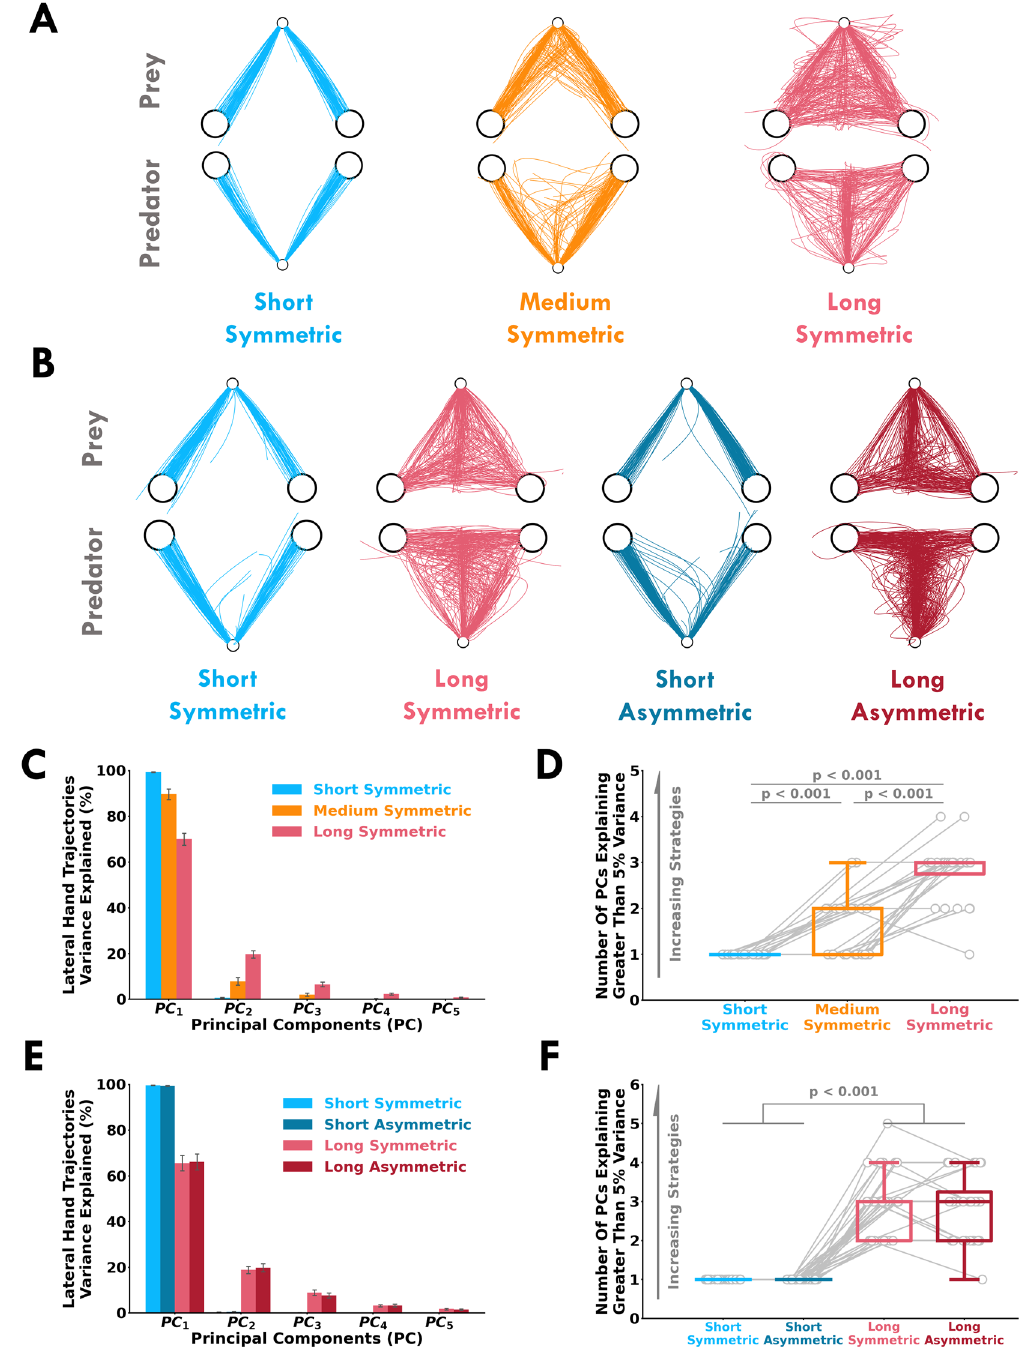
Figure 2. Individual and group movement behaviour. Sample hand trajectories of an exemplar human pair (predator top row, prey bottom row) for all trials within each condition for ( A ) Experiment 1 and ( B ) Experiment 2. Lateral hand trajectory variance explained ( y-axis ) by the first five principal components ( x-axis ) for ( C ) Experiment 1 and ( E ) Experiment 2. Error bars represent ± 1 standard error. Number of principal components explaining greater than 5% variance ( y-axis ) within each condition ( y-axis ) for ( D ) Experiment 1 and ( F ) Experiment 2. The open gray circles and connecting gray lines correspond to individual participants. Box plots show 25th, 50th, and 75th percentiles. Here we see an increase in movement complexity with more available time, which suggests participants used an increased number of strategies to mislead and react to an